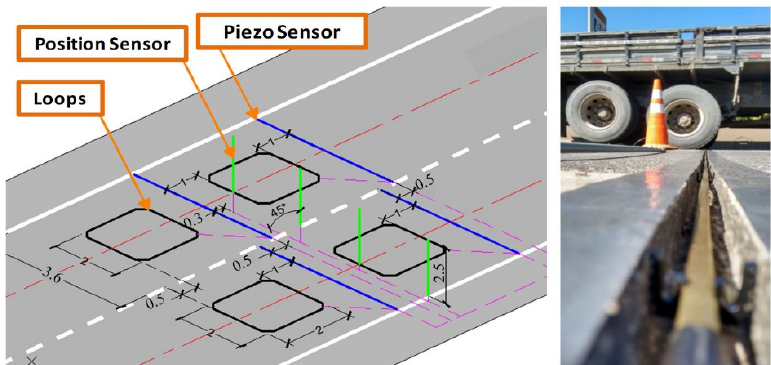
Figure 3. HS-WIM system in BR-381 (MG-SP) and weighting sensor before grout (adapted from Portela [15]).